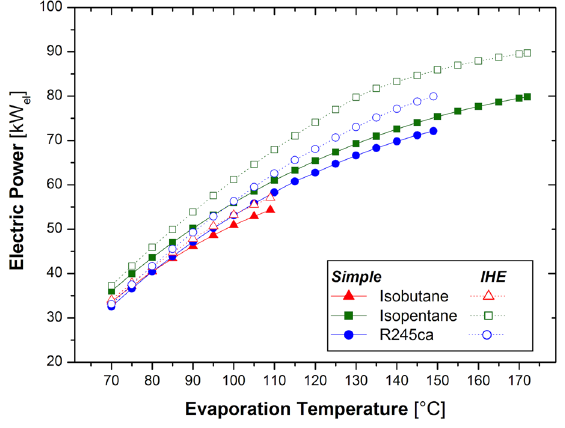
Figure 7. Effect of evaporation temperature on ORC electric power (subcritical cycle).